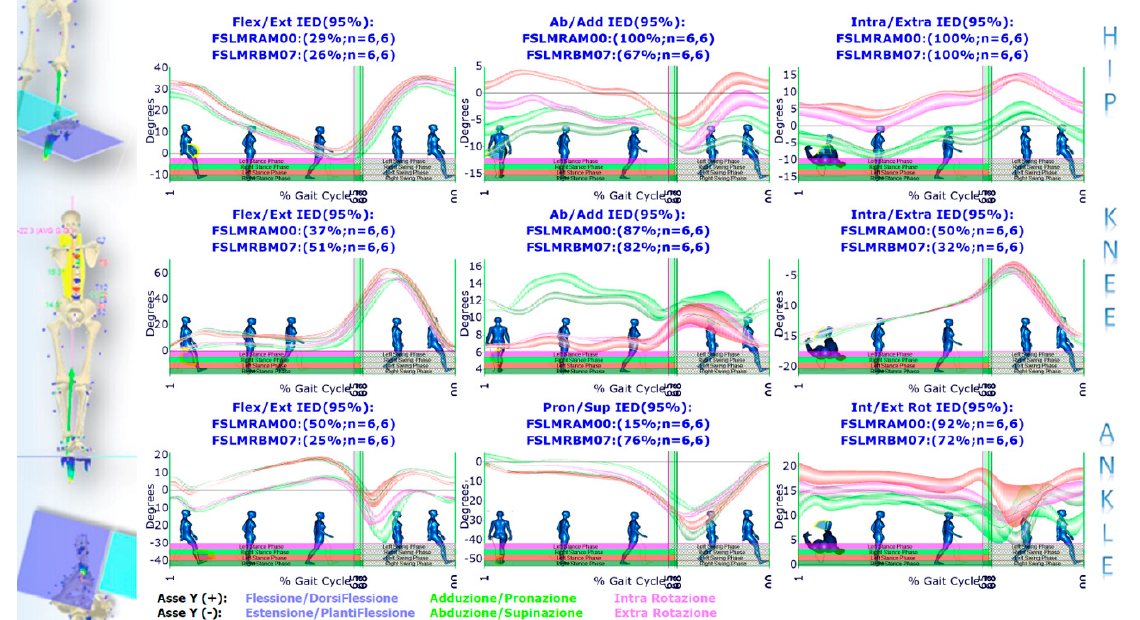
Figure 10. Average gait cycle: joint angles of the lower limbs. Each panel shows the left (red colours) vs. right leg (green colours) comparison in the following conditions: barefoot walking in the initial evaluation (darker colours, file name code FSLMRAM00) and walking with foot orthosis during the control session (lighter colours, file name code FSLMRAM07). The following information is listed in brackets: (1) IED values; (2) the number of valid strides included in the averaging process. From the IED analysis, it is possible to notice a reduction of the general asymmetry passing from the first to the second condition.